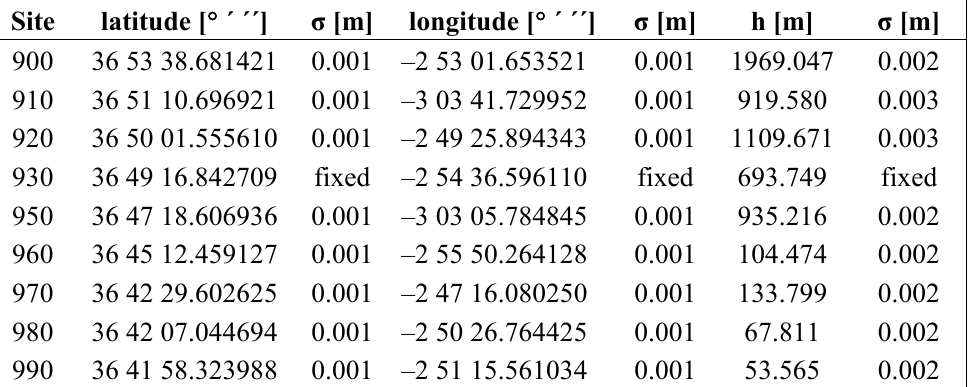
Table 4. ITRF2000 geodetic coordinates at epoch